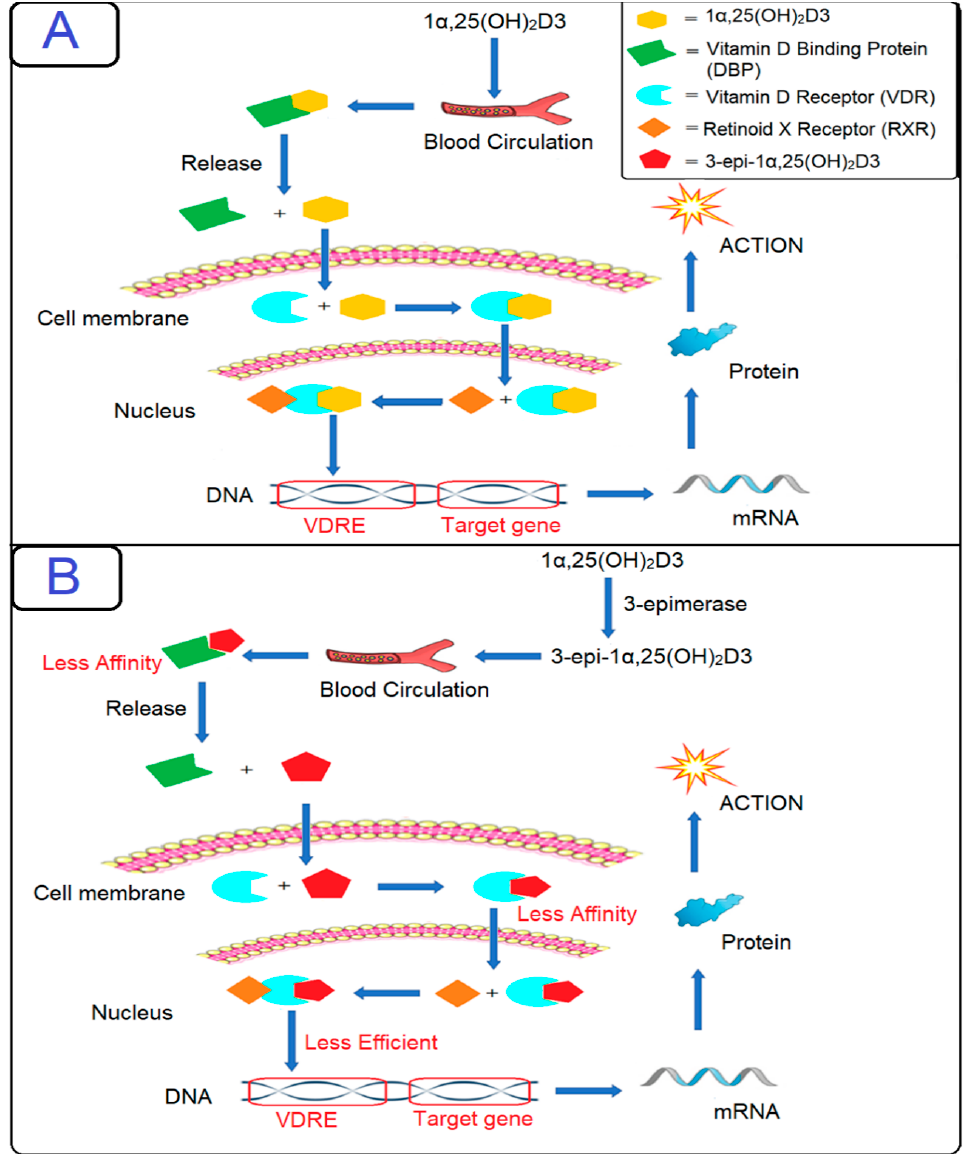
Figure 3. Comparison between 1 α ,25(OH) 2 D3 and 3-epi-1 α ,25(OH) 2 D3 in terms of gene regulation. ( A ) When 1 α ,25(OH) 2 D3 is released from DBP, it will cross the cell membrane and enter the target cell to bind with VDR. The 1 α ,25(OH) 2 D3–VDR complex undergoes translocation to the nucleus and performs conformational changes in order to link with other transcriptional factors and heterodimerize with RXR. After that, the 1 α ,25(OH) 2 D3–VDR–RXR complex binds to the vitamin D response element (VDRE); then, the transcription of RNA begins for the specific genes that are then expressed as different proteins responsible for vitamin D homeostasis. ( B ) We assume that 3-epi-1 α ,25(OH) 2 D3 will carry out the same function but at a slower rate. The 3-epi-1 α ,25(OH) 2 D3 complex could likely perform the same gene regulation as its non-epimeric forms but at a lower rate.